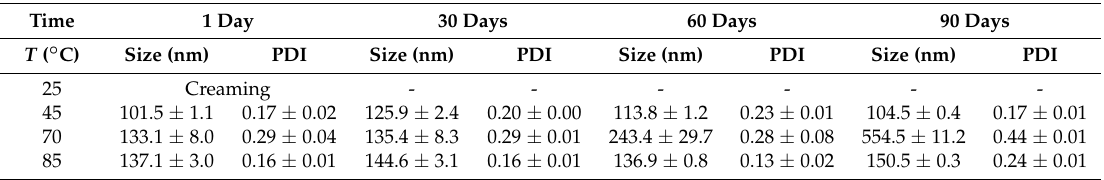
Table 1. Influence of emulsification temperature on droplets size distribution and stability.